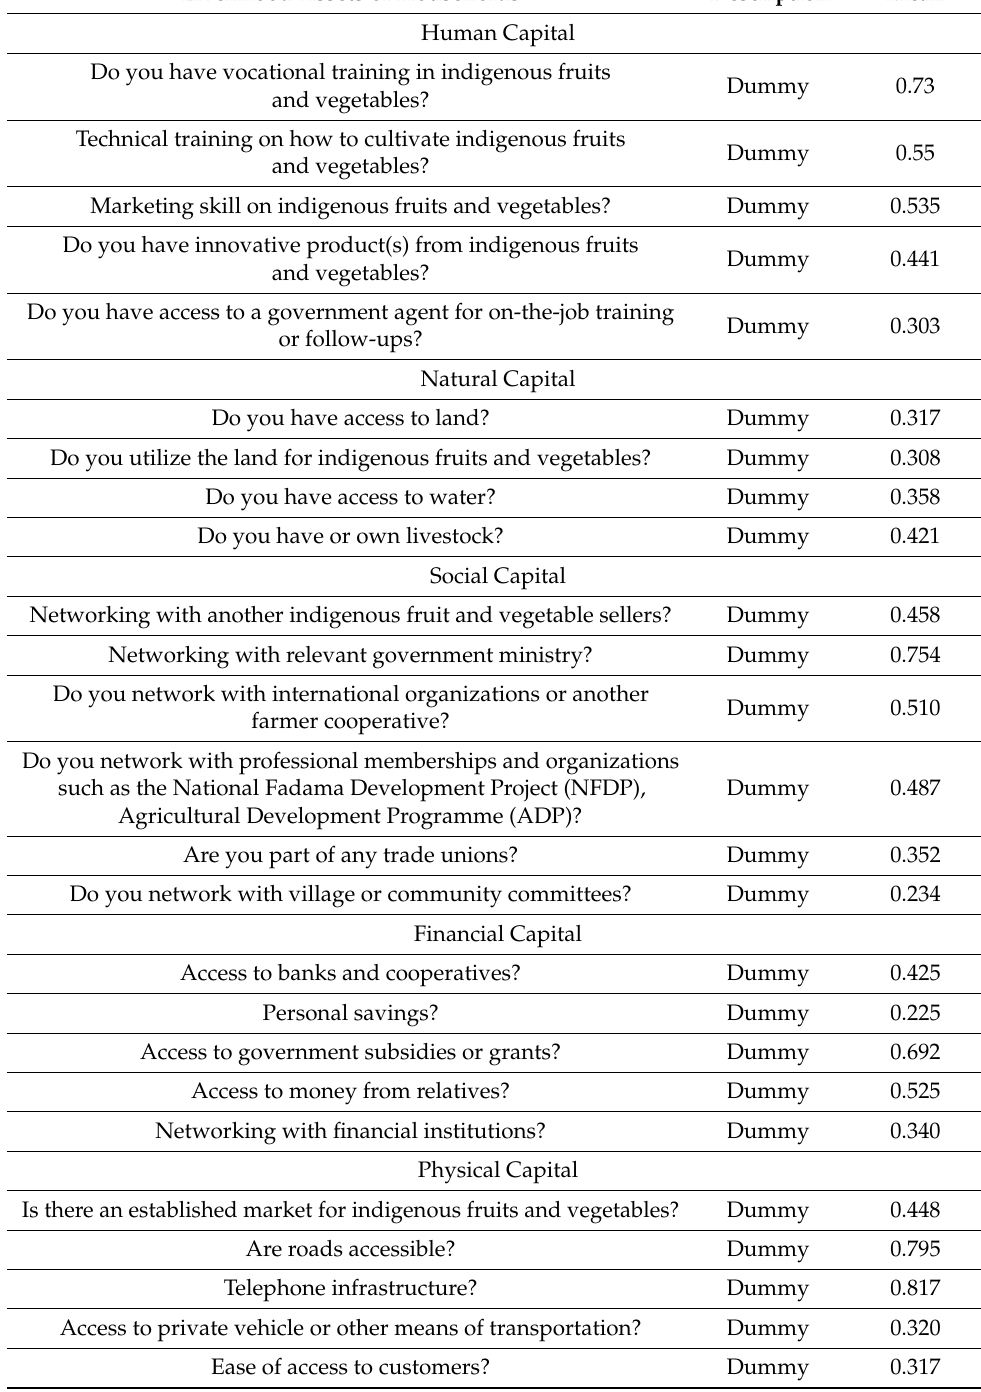
Table 3. Dummy variable used to generate composite livelihood asset